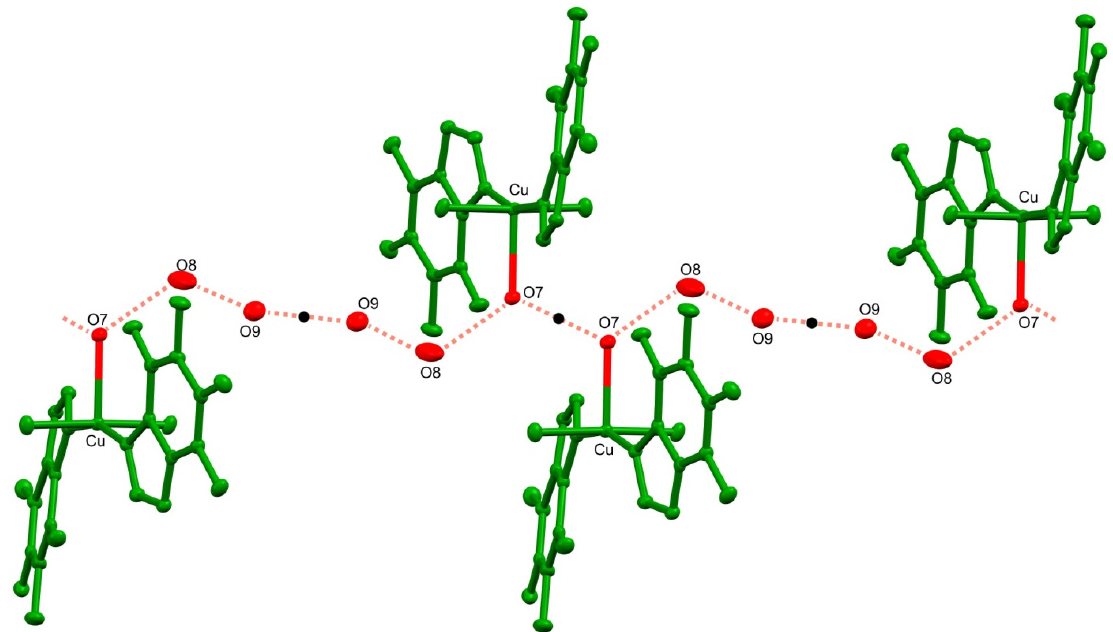
Figure 2. Fragment of the double palindrome water chain in 1 running along the [100] direction. Symmetry centers are indicated with black dots. Hydrogens atom are omitted for clarity. Table 2. Hydrogen bond geometry in 1 (°, Å). H7A, H8A, and H9A atoms are disordered over two sites, their secondary positions are labeled H7B, H8B, and H9B, respectively. All of those sites participate in hydrogen bonding.